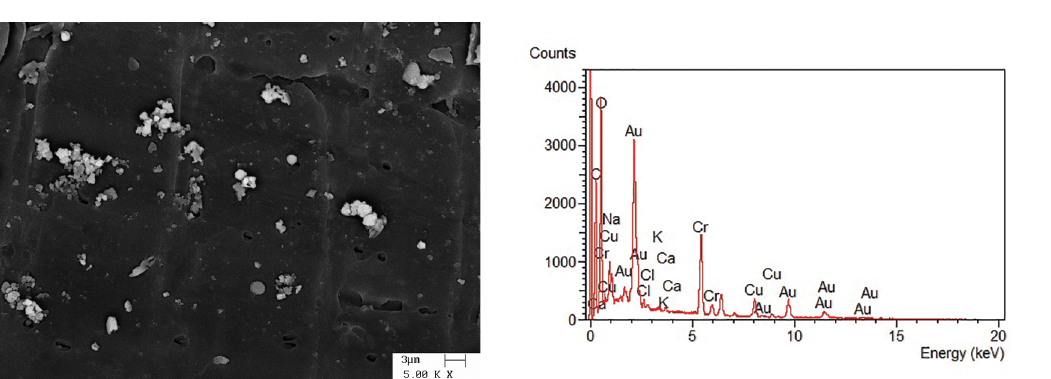
Figure 4. SEM micrography with 5000x magnification of Caixeta wood cells with CCB.